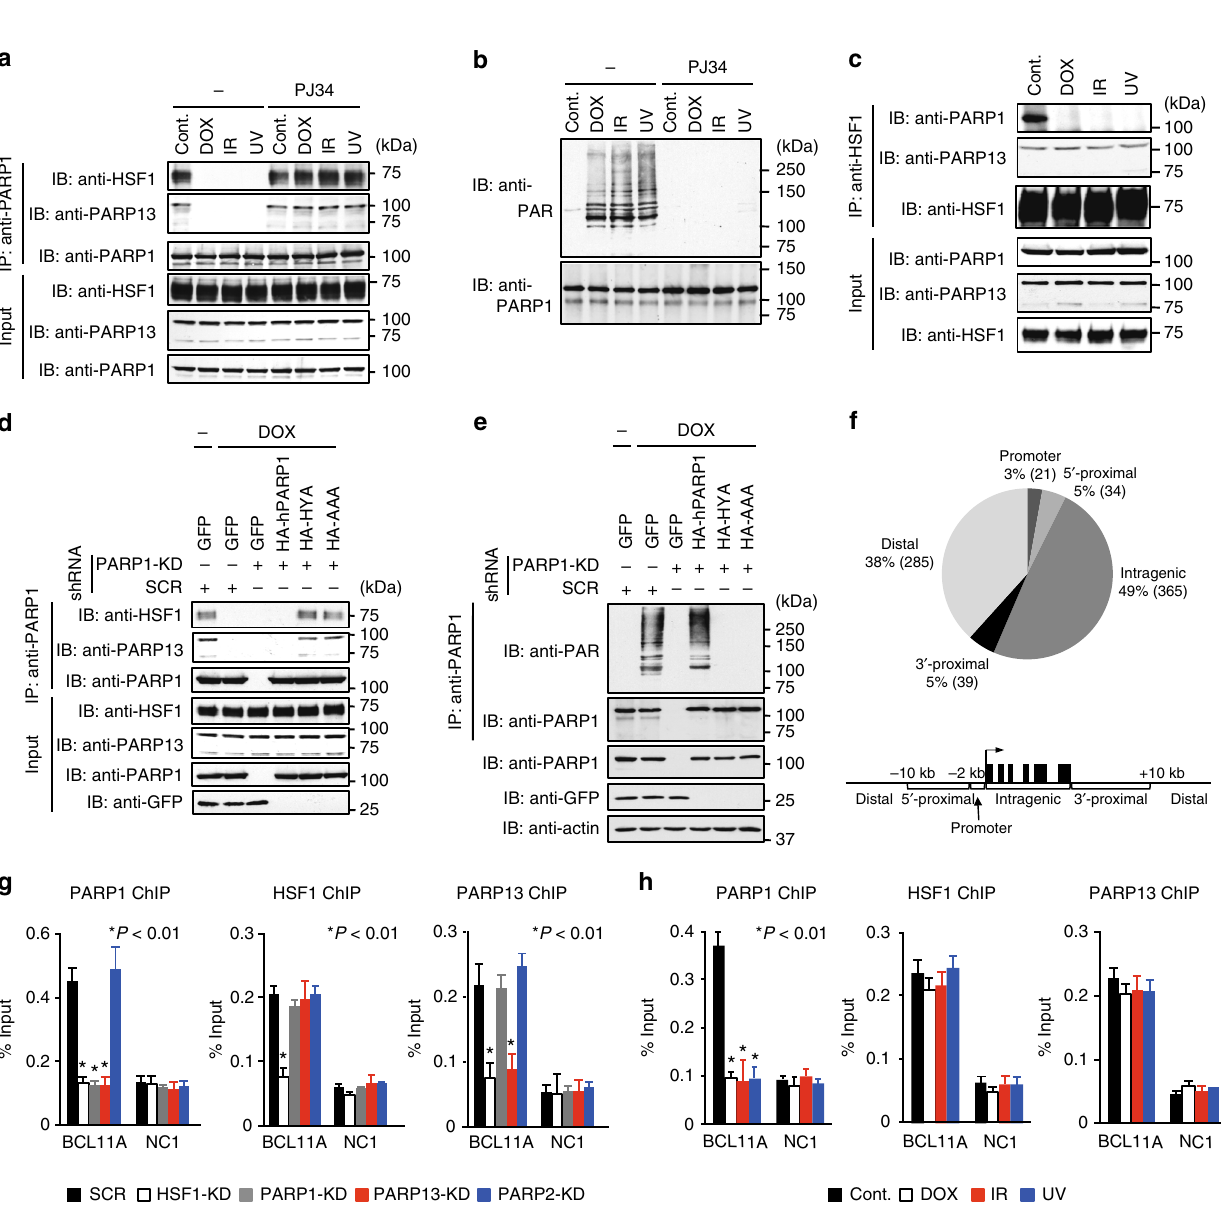
Fig. 2 PARP1 activity regulates HSF1 – PARP13 – PARP1 ternary complex formation. a Extracts of cells treated with DOX, IR, or UV in the presence or absence of PJ34 were subjected to PARP1 immunoprecipitation, and then to immunoblotting. b Denatured extracts of cells treated as described in a were subjected to PARP1 immunoprecipitation, and then to immunoblotting using PAR antibody. c Extracts of cells treated as described in a were subjected to HSF1 immunoprecipitation, and then to immunoblotting. d Cells, in which endogenous PARP1 was replaced with wild-type or its inactive mutant, were treated with DOX. Cell extracts were subjected to PARP1 immunoprecipitation and immunoblotting. e Denatured extracts of cells treated as described in d were subjected to PARP1 immunoprecipitation, and then to immunoblotting using PAR antibody. f Genomic distribution of PARP1. ChIP-seq analysis was performed using LMB-treated cells overexpressing HA-hPARP1 and hHSF1-HA, and a total of 744 PARP1 peaks were identi fi ed. Percentages and numbers of PARP1 peaks at genomic regions relative to nearby genes are shown. Among 744 PARP1 peaks, only 10 peaks (Intragenic, 4; 3 ′ -Proximal, 1; Distal, 5) were identi fi ed after PARP13 knockdown. g ChIP assay of PARP1, PARP13, and HSF1 at BCL11A locus in HeLa cells, in which PARP1, PARP13, HSF1, or PARP2 were knocked down. ChIP-qPCR on the peak region (BCL11A) and negative control region (NC1) was performed ( n = 3). h ChIP assay at BCL11A locus